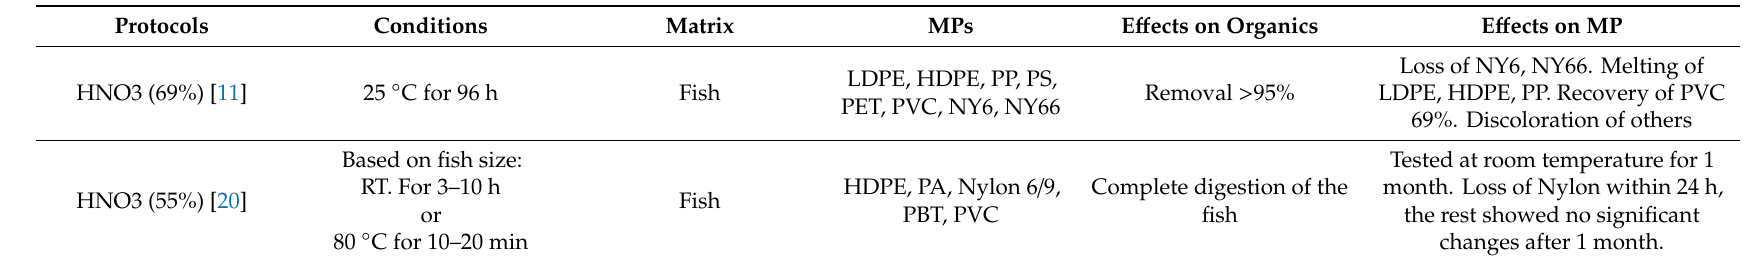
Table A3. Summary of various acid-based digestions used in microplastic studies. RT—Room